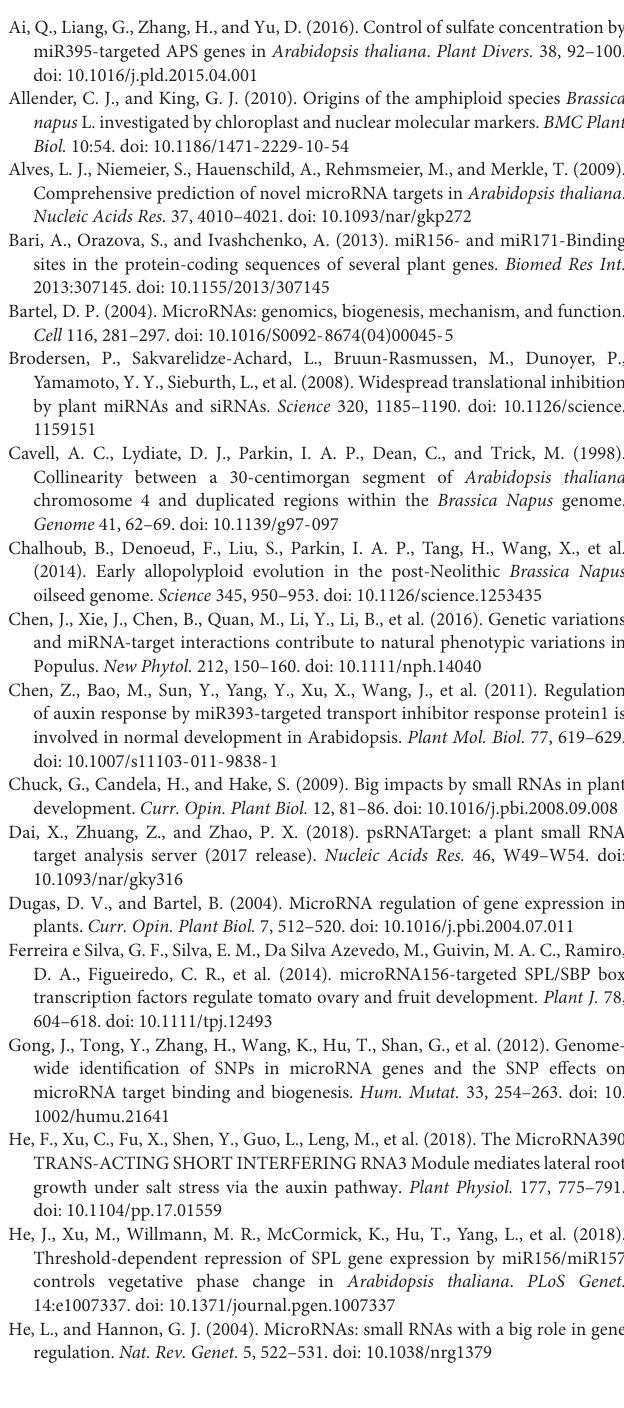
Supplementary Table 10 | SNPs and INDELs in miRNA target sites in rapeseed accessions. Supplementary Table 11 | Analysis of variance of the 12 observed agronomic traits. Significant differences were determined by F -test (ANOVA) using the SAS software. The letter “A” and “B” represent significant differences at the 1% level.